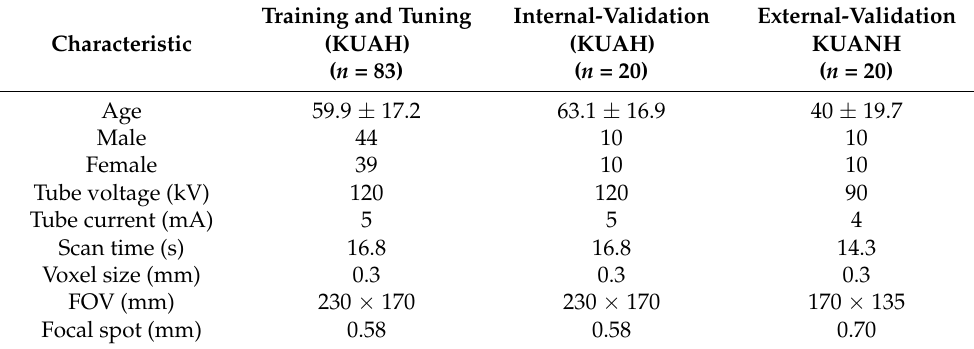
Table 1. Characteristics and acquisition parameters of the study population by